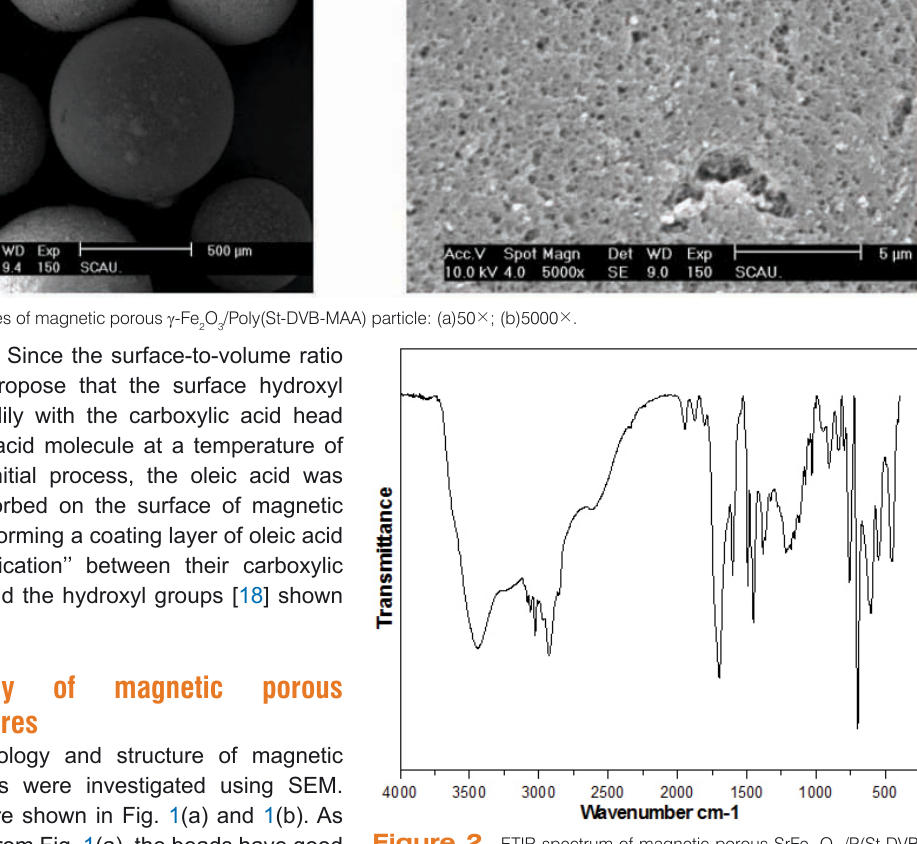
O /P(St-DVB- 12 19